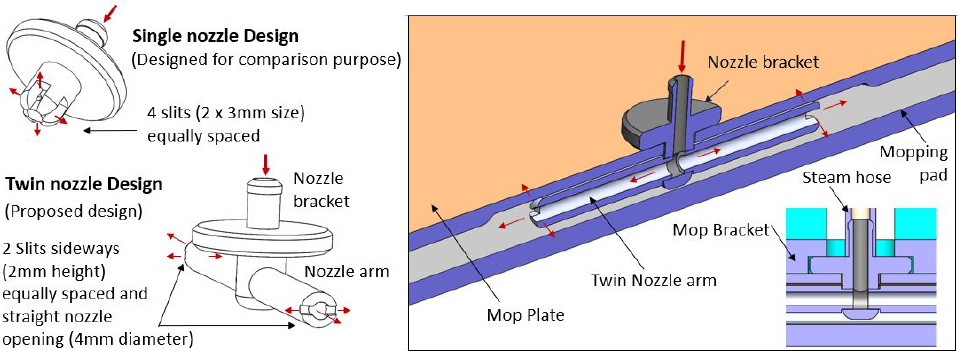
Figure 4. Nozzle designs and proposed twin-nozzle